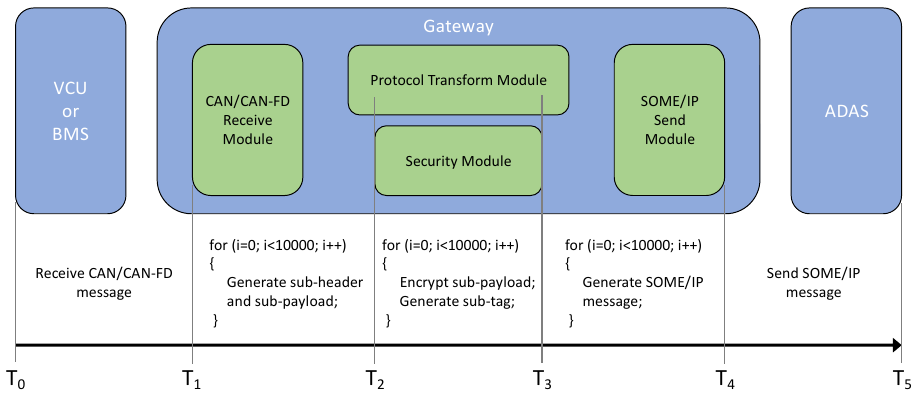
Figure 11. Latency indication of the designed gateway system.